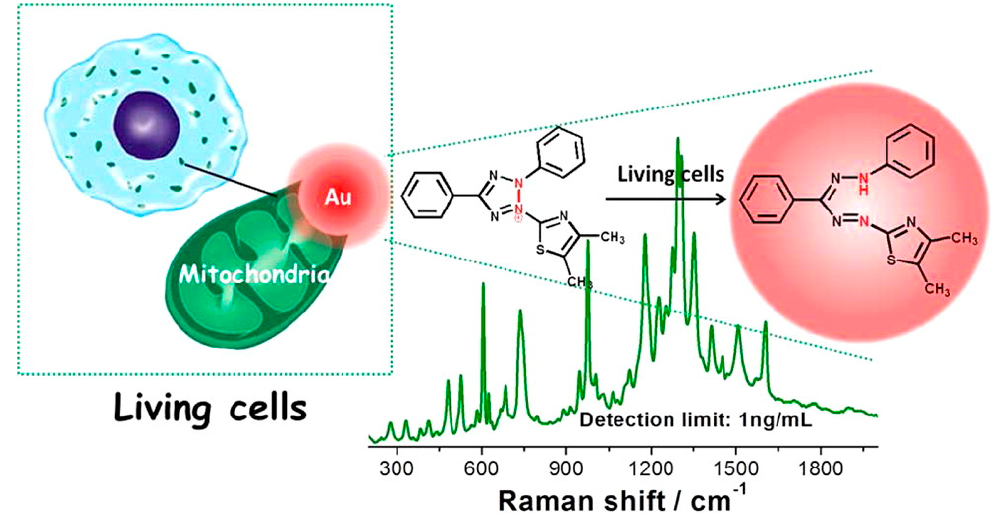
Figure 5. Schematic of the detection of cell activity based on the SERRS-MTT assay. (Reproduced with permission from [91]. Copyright 2013, ACS.)